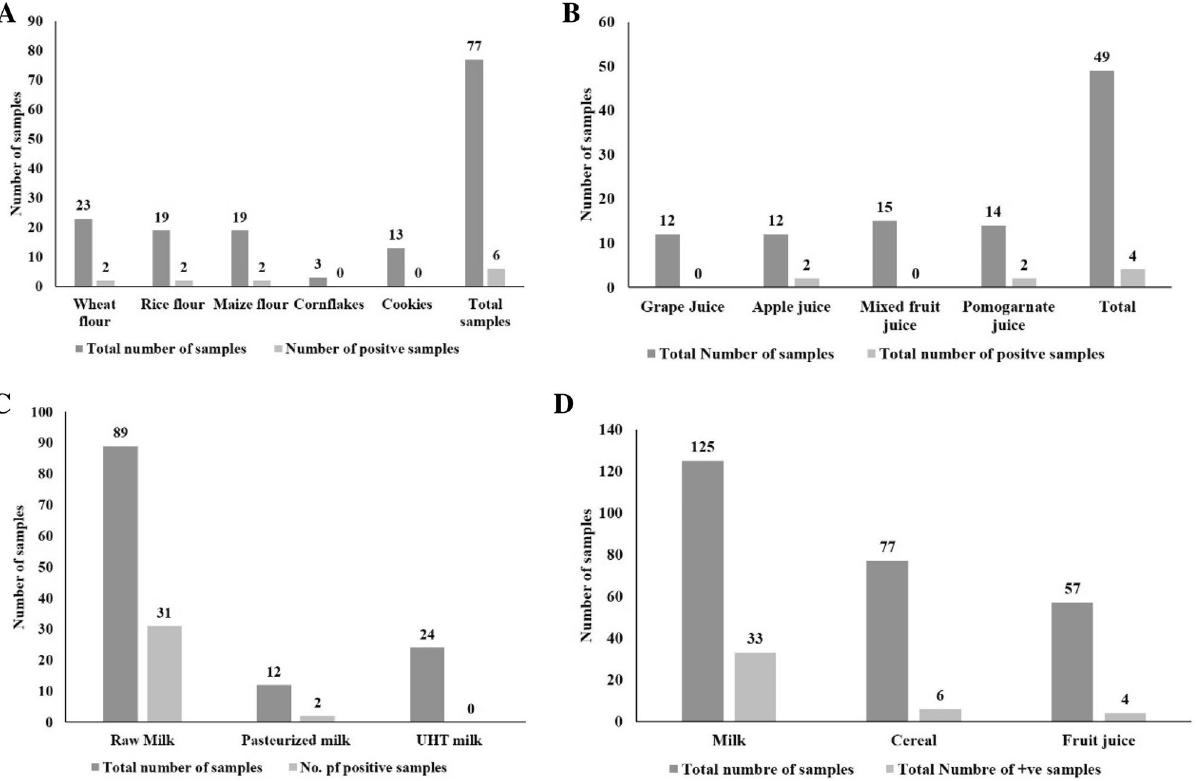
Figure 2. Screening of food sample using paper strip assay. ( A ) Incidence of pesticide residues in cereal based products. ( B ) Incidence of pesticide residues in Fruit juices. ( C ) Incidence of pesticide residues in milk samples. ( D ) Overall incidence of pesticide